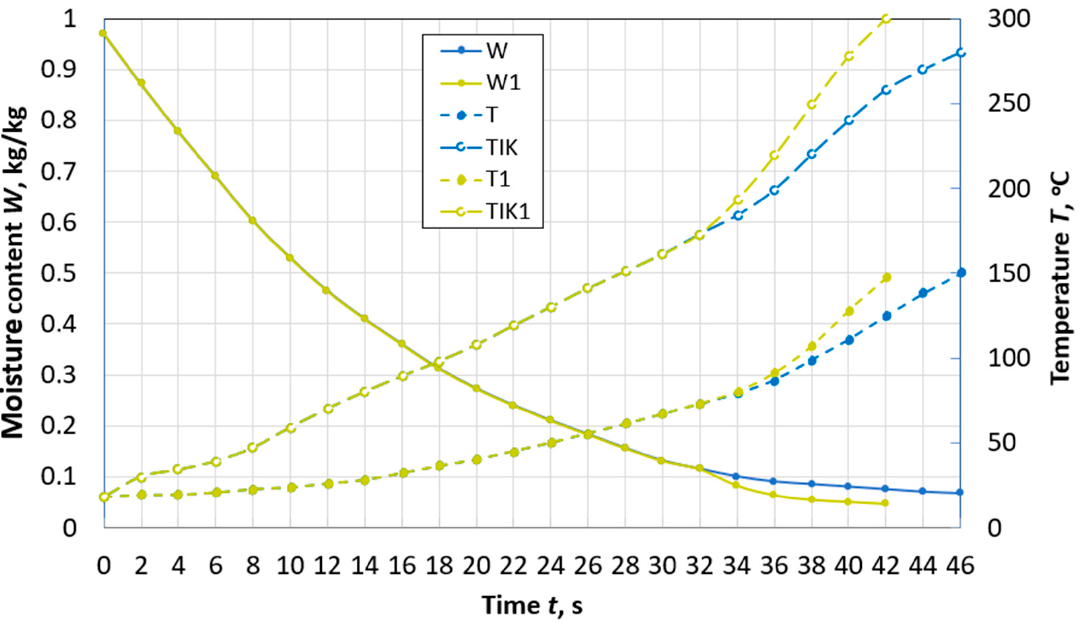
Figure 4. Changes over time in the average moisture content W and temperature T , temperature T IK on the surface of a spherical particle of peat with a diameter of d = 10 mm during drying with and without taking into account thermal destruction ( W 1, T 1, T IK 1) in the flow of flue gases with the parameters: Т e.m. = 300 ° С , w e.m. = 4 m/s, d e.m. = 12 g/kg of dry gas.